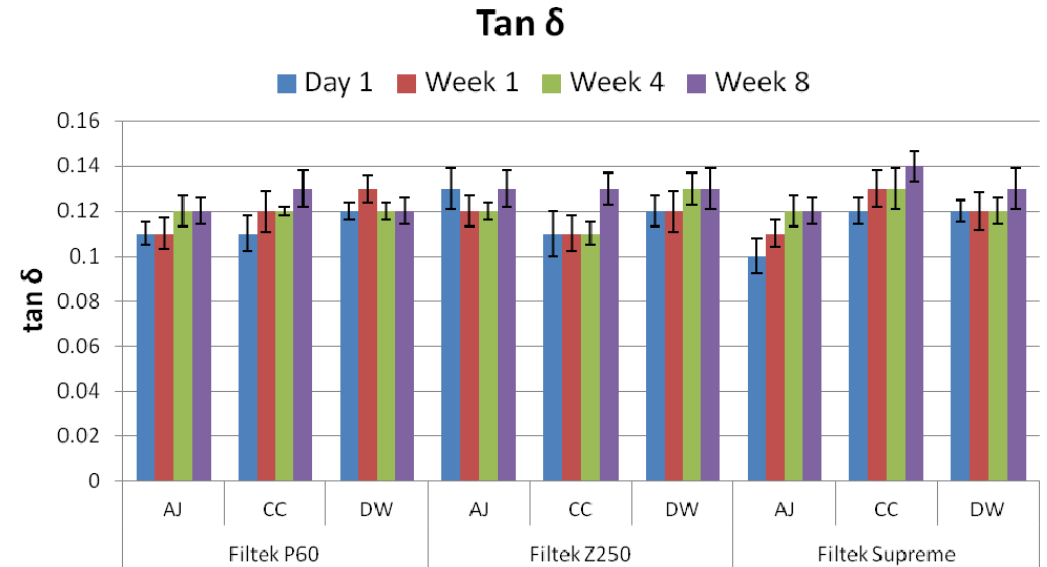
Figure 2. Comparative tan delta values of Z250, Filtek™ P60 and Filtek™ Supreme after immersion in apple juice (AJ), Coca-Cola (CC) and deionized water (DW) for one